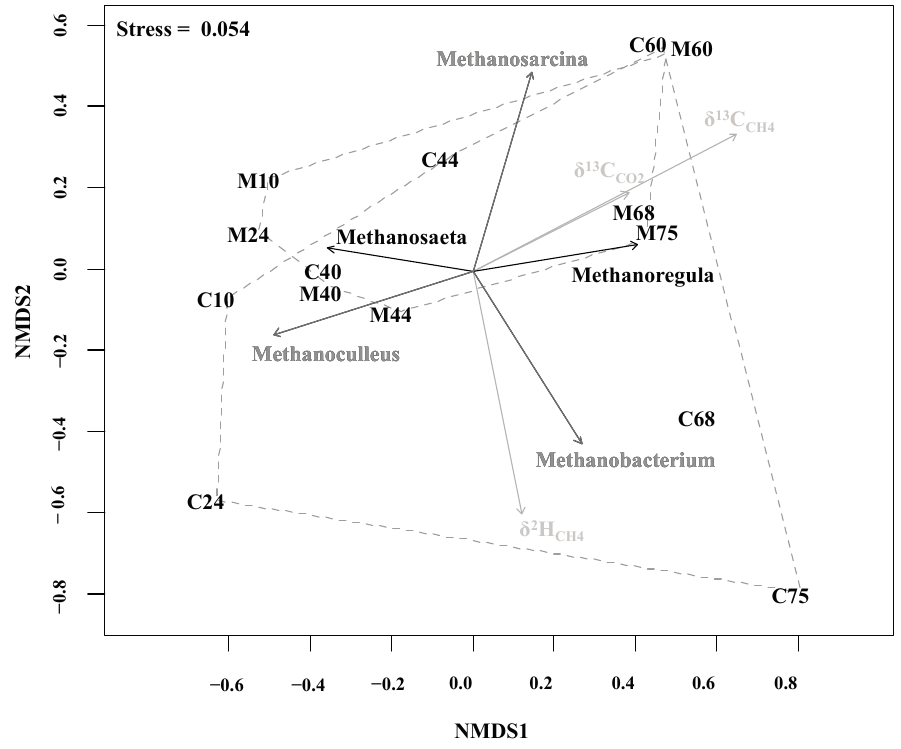
Figure 4. NMDS analysis plot for correlating the T-RFLP profile of methanogens with the isotope composition of produced biogas. The smaller and bigger hull in the diagram represents the mono- and co-digestion in several sampling time, respectively. The letter M stands for mono-digestion and C for co-digestion set-up and the following numbers correspond to the sampling day. The dim grey and black arrows indicate the highly significant ( p < 0.001) and significant ( p < 0.05) correlations, respectively. Grey arrows indicate the correlation vectors of community differences and the isotope composition at lower significance ( p < 0.5). Monte-Carlo permutation was used to test the significance against 999 random data sets. The direction of the arrows show the correspondence to the community structures and the length of the arrow indicate the strength of the correlation with the ordination